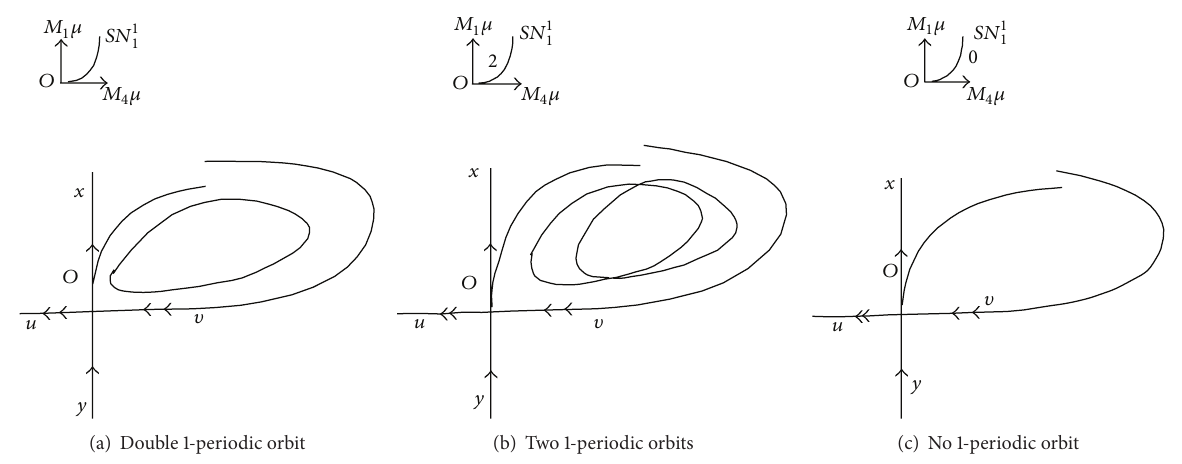
Figure 2: Rank (𝑀 1 ,𝑀 4 ) = 2 and 𝜇 ∈ 𝐸 11 1 ∩ 𝑅 11 14